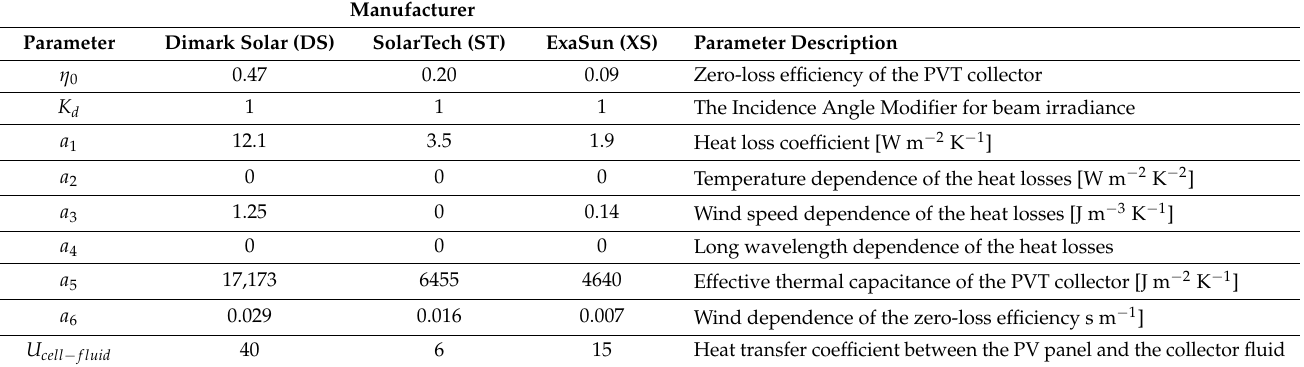
Table 9. Thermal model parameters for the different PVT collectors. Adopted values from [19].